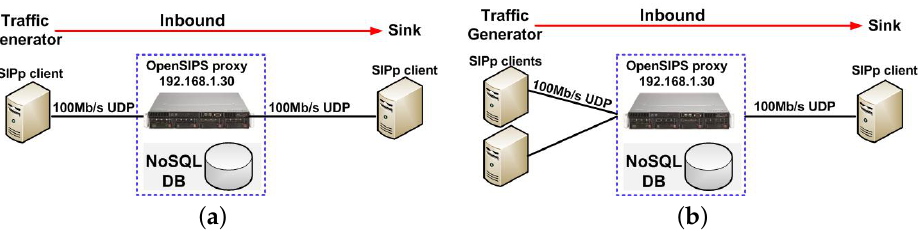
Figure 1. Testing topology ( a ) single client ( b ) multi